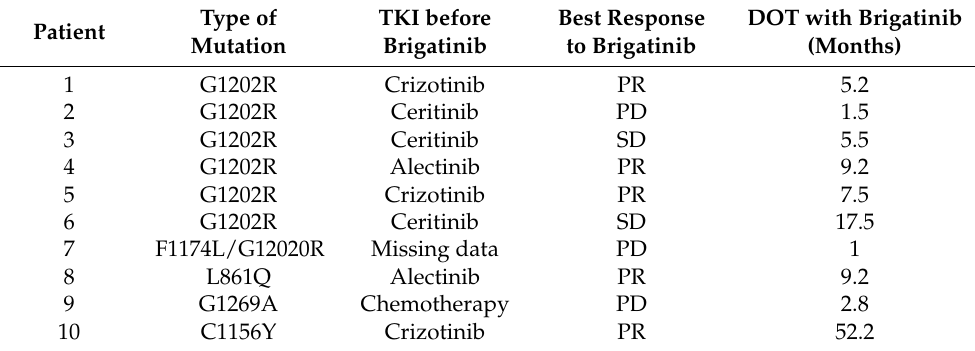
Table 3. Secondary mutations identified before brigatinib treatment ( n = 10): best response and DOT with